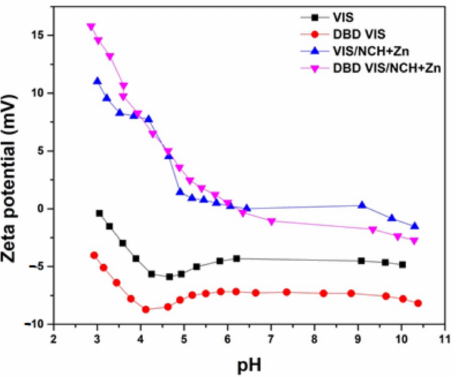
Figure 3. Zeta potential of unmodified and DBD-modified viscose fabrics before and after functional- ization with NCH+Zn. Part of results were previously published in [5,6,11].